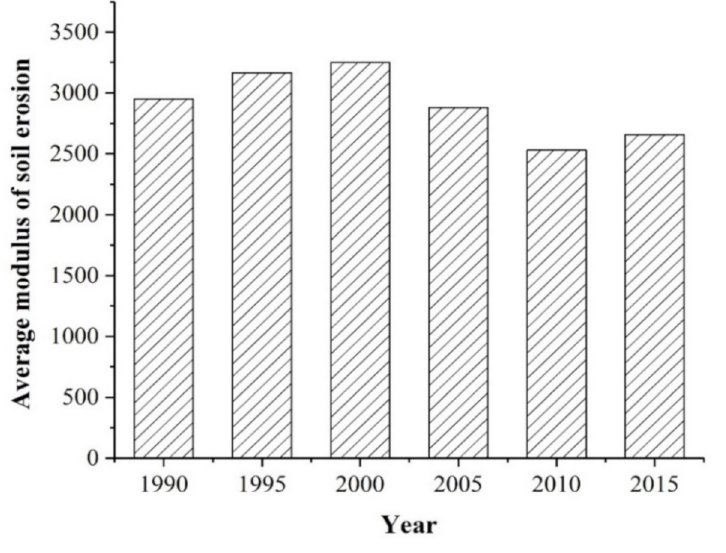
Figure 5. Average annual soil erosion module of the TGRA between 1990 and